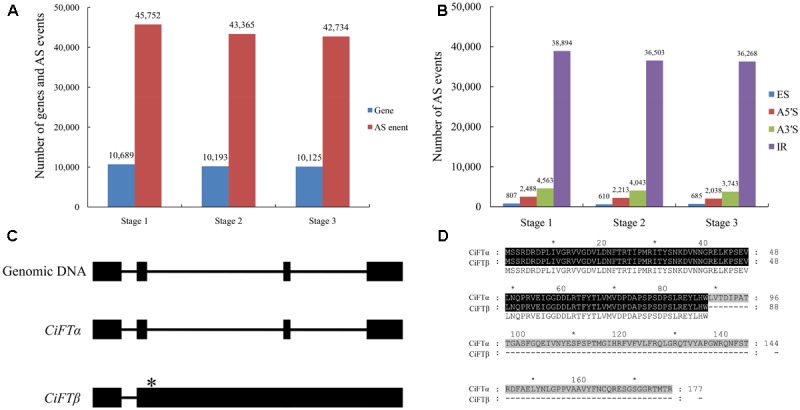
Large-scale identification of alternative splicing (AS) by RNA sequencing during floral inductive water deficits. (A) The AS events and genes at different stages (stage 1: 1 week before water deficit; stage 2: 1 week after the beginning of water deficit; and stage 3: 1 week after releasing from water deficit). (B) The different types of the AS events at different stages (stage 1: 1 week before water deficit; stage 2: 1 week after the beginning of water deficit; and stage 3: 1 week after releasing from water deficit). ES, skipped exons; RI, retained introns; A5SS, alternative 5′-splice sites; A3SS, alternative 3′-splice sites. (C) The structural comparison between the CiFT genomic sequence and putative AS transcripts of CiFT (CiFTα and CiFTβ), asterisk indicates location of termination codon. (D) The sequence analysis of CiFTα and CiFTβ protein.